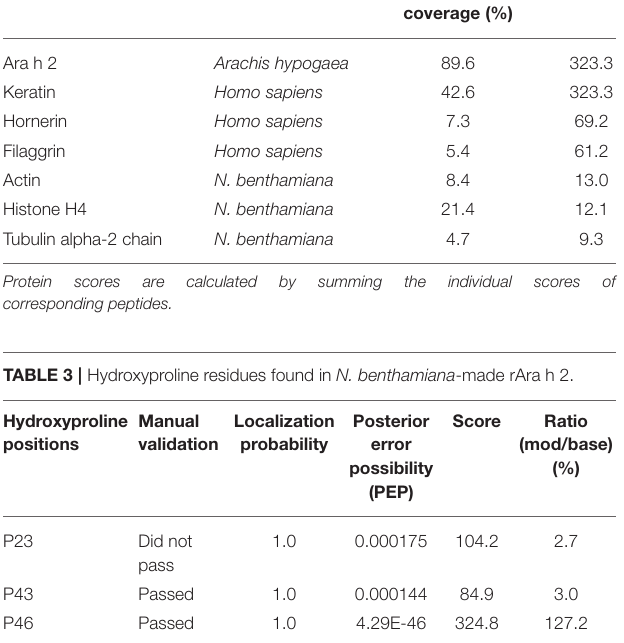
TABLE 4 | Comparison of manually confirmed site-specific hydroxylations of proline residues in rAra h 2 from N. benthamiana and in the natural allergen. Hydroxyproline Adjacent positions